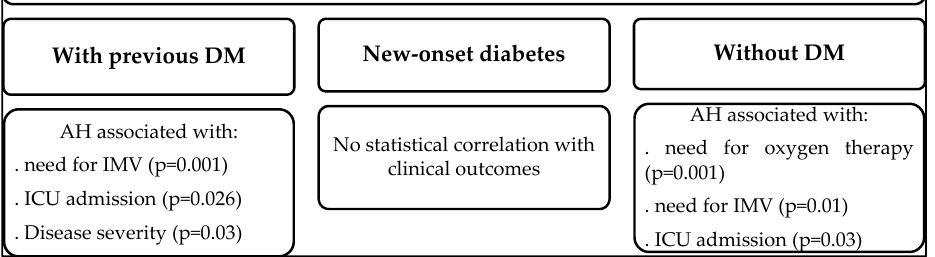
Figure 2. Summary of the results of our study (AH, At-admission hyperglycemia; AN, At-admission normoglycemia; DM, Diabetes mellitus ; ICU, Intensive Care Unit; IMV, Invasive Mechanical Ventilation; n, number; NS—nonsignificant).